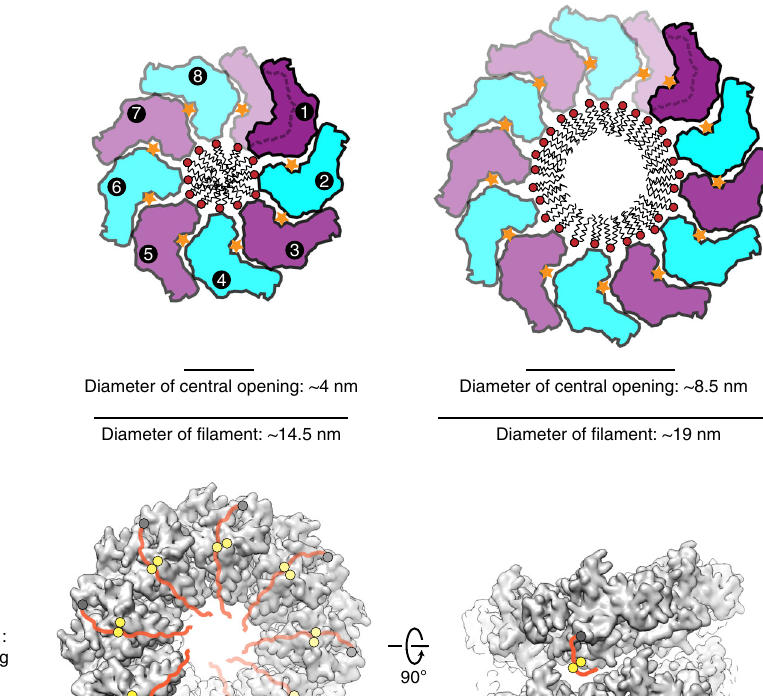
membrane-free fi laments (Fig. 3g). Assuming a monolayered protein coat, we can estimate a membrane structure with a dia- meter of ~8.5 nm size (Fig. 6a), since the protein coat thickness itself would be close to the one observed in the membrane-free environment.